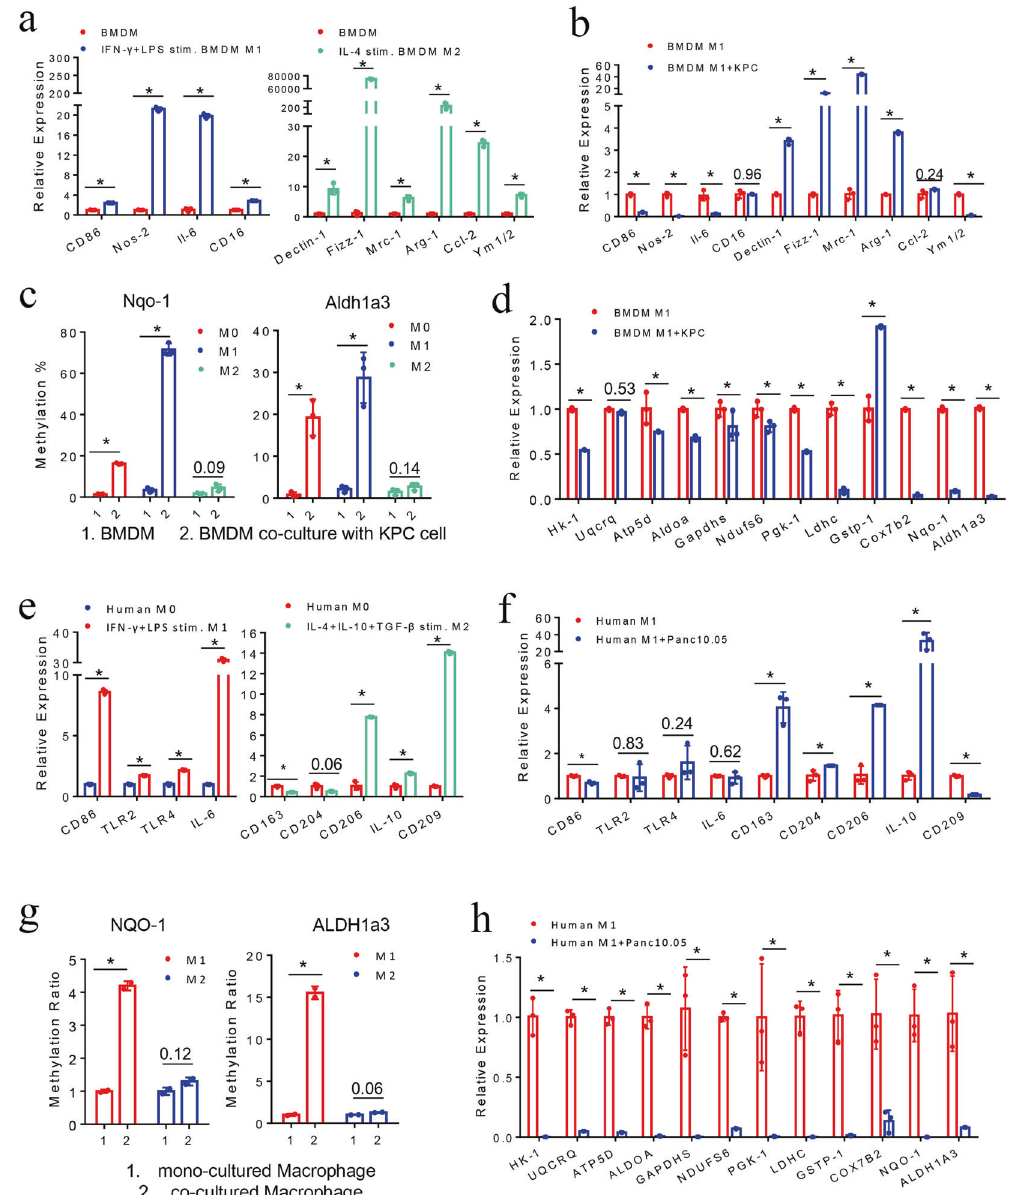
Fig. 3 M1-like, but not M2-like macrophages are selectively reprogrammed by tumor-induced methylation. a Phenotypic characterization of mouse BMDMs after IFN- γ /LPS-induced M1 polarization and IL-4-induced M2 polarization. mRNA expression of M1 and M2 marker genes measured by RT-PCR with β -actin used for normalization. b M1 and M2 marker gene expression in mouse M1-like macrophages after co- culturing with KPC cells. c Aldh1a3 and Nqo-1 methylation in mouse M0, M1-like, and M2-like macrophages upon co-culturing with KPC cells. d RT-PCR of key genes in glucose metabolism and OXPHOS pathways in mouse M1-like macrophages after co-culturing with KPC cells. e Phenotypic characterization of human macrophages after IFN- γ /LPS-induced M1 polarization and IL-4/IL-10/TGF- β -induced M2 polarization. f RT-PCR of M1 and M2 marker genes in human M1-like macrophages after co-culturing with Panc10.05 cells. g ALDH1a3 and NQO-1 methylation in human M1-like and M2-like macrophages upon co-culturing with Panc10.05 cells. * P < 0.05 (paired t test). h RT-PCR of key genes in glucose metabolism and OXPHOS pathways in human M1-like macrophages after co-culturing with Panc10.05 cells. Data are means ± SEM from technical duplicates. * P < 0.05 (All panels except g used Mann – Whitney U